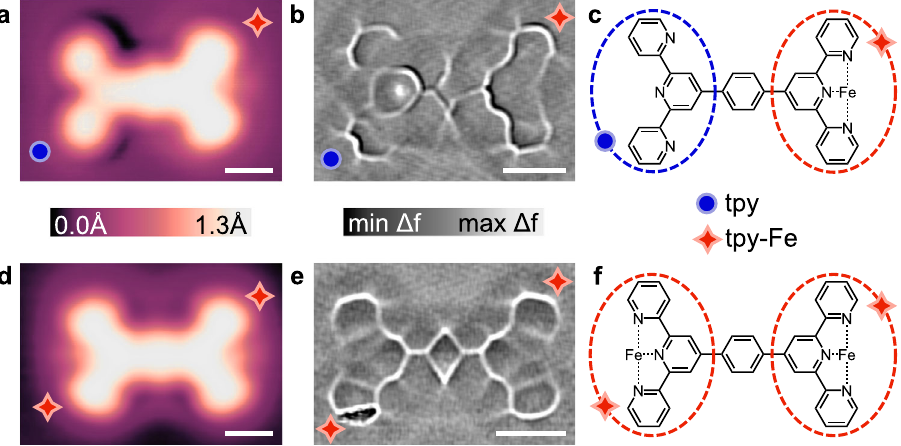
Fig.1|STMandncAFMofFe-tpysites. TPTmoleculewithone( a – c )andtwo( d – f ) active Fe-tpy sites. STM images ( a , d ) acquired with CO-functionalized tips. STM topograph with single Fe-tpy site ( a ) acquired at V =20mV and I =10pA indicates anincreaseinapparentheightattheFe-tpycoordinatebond( a ,redfour-pointstar)